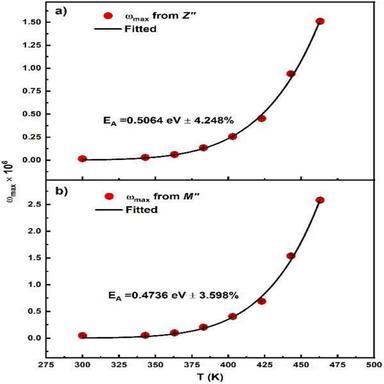
Variation of ωmax of a) Z''/Z''max and b) M''/M''max with temperature ranging from RT to 190 ◦C.